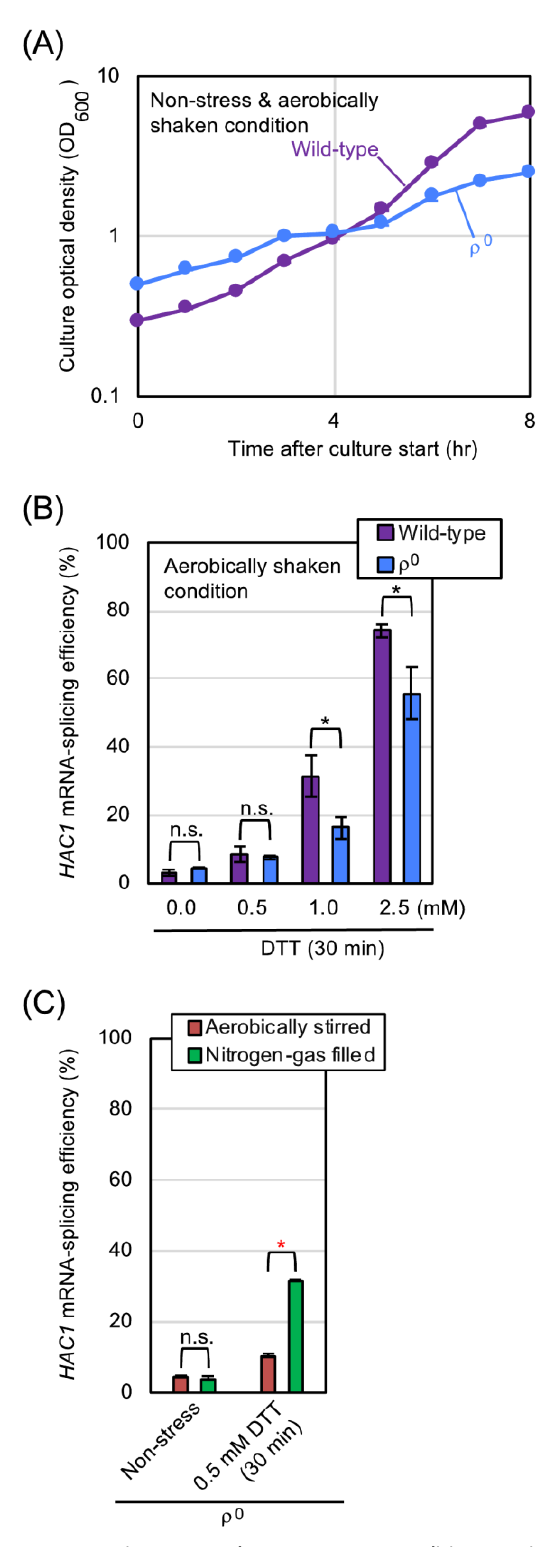
FIGURE 4: Hypoxic treatment boosts HAC1 -mRNA splicing even in  o mutant cells. (A) and (B) Wild-type BY4742 cells and the congenic  o mutant were cultured (or ER-stressed by the indicated concentrations of DTT for 30 min) under the aerobically shaken condition at 30°C in YPD, and were checked for optical culture density and HAC1 -mRNA splicing. (C) The  o mutant cells used in panels A and B were cultured and ER-stressed as shown in Fig. 2A, and were checked for HAC1 -mRNA splicing. n.s. (not significant): p > 0.05, *: p < 0.05, **: p <